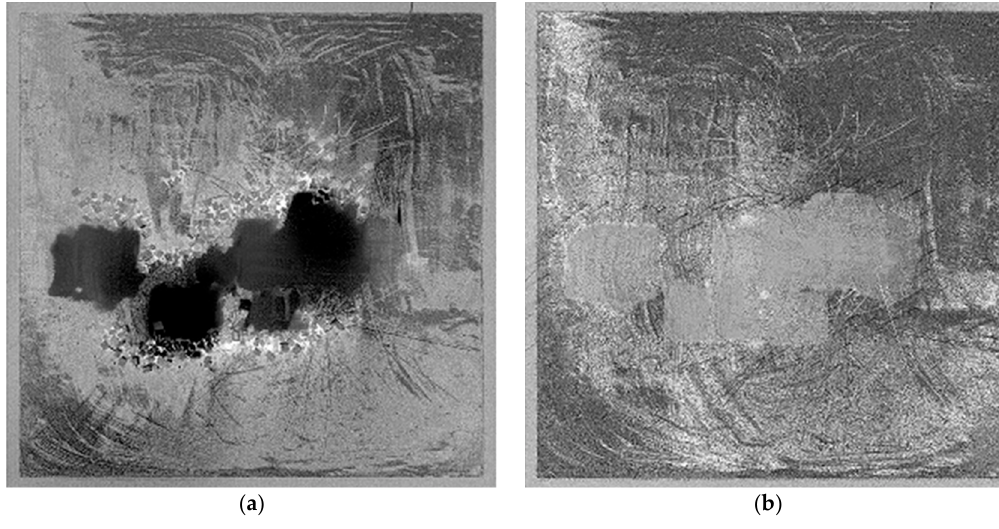
Figure 17. Ronen Sharabani, ( a ) Cistern #1 , ( b ) Cistern #2 , from the series Virtual Territories , 2019. Digital prints, 100 cm × 100 cm each.